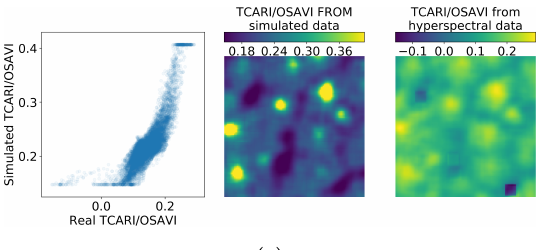
Figure 10. Comparison between simulated and empirical TCARI calculated from data simulated using SLOP. ( a ) corresponds to the research plot 1, ( b ) to plot 2, ( c ) to 3, ( d ) to 4, ( e ) to 5, ( f ) to 6 and ( g ) to 7.